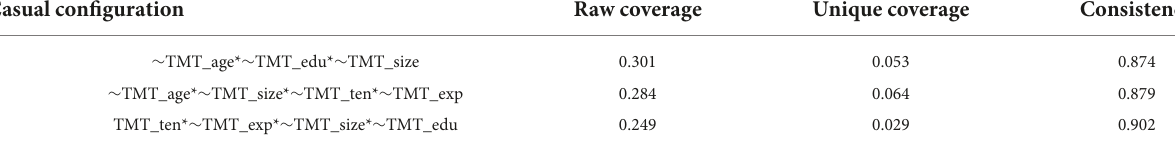
TABLE 5 Results of both the parsimonious and intermediate solution of